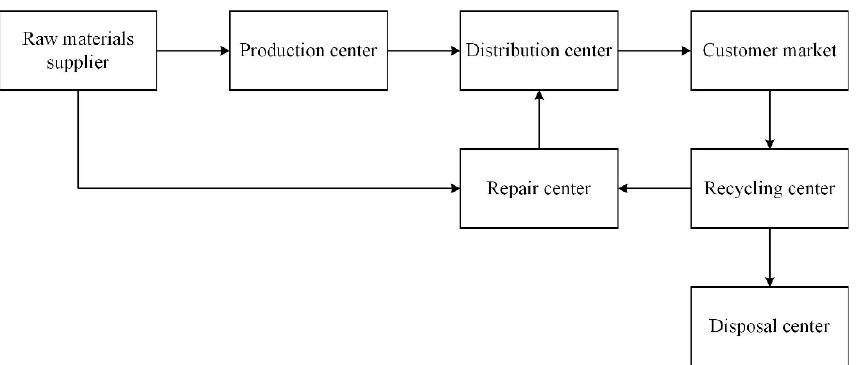
Figure 1. The generic network of sustainable closed-loop supply chain.